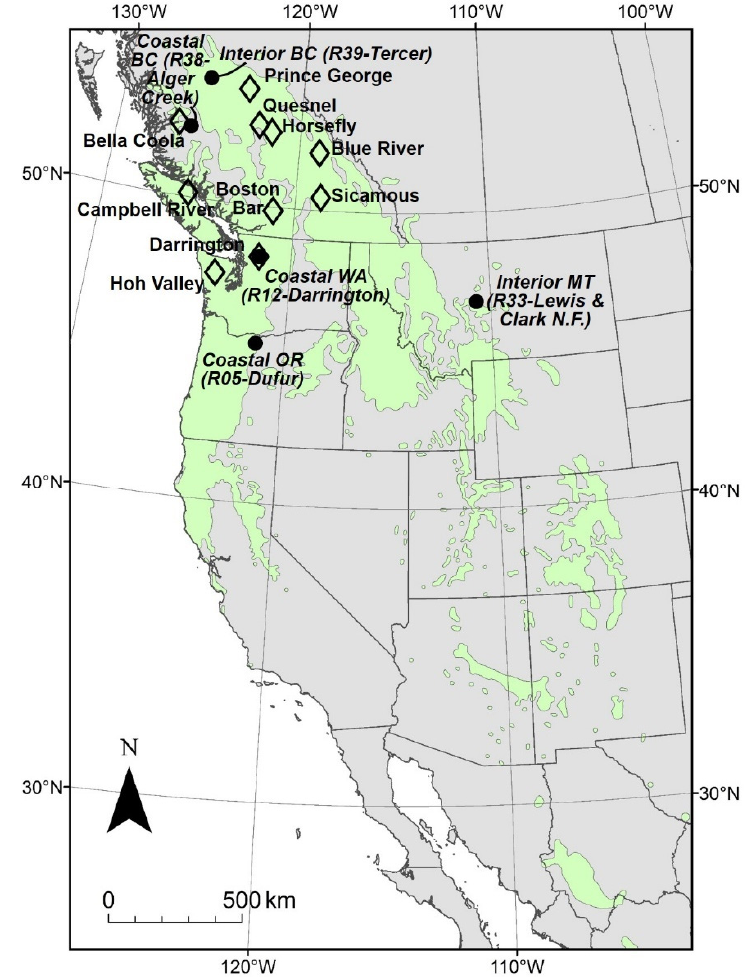
Figure 1. Provenances with a documented native origin. Documented native provenances of the genotyped Swedish clones are marked with empty diamonds, reference provenances used for molec- ular genetic assignment are marked with black filled circles and labels in italics. The distribution area of Douglas fir is shown with light green colour.